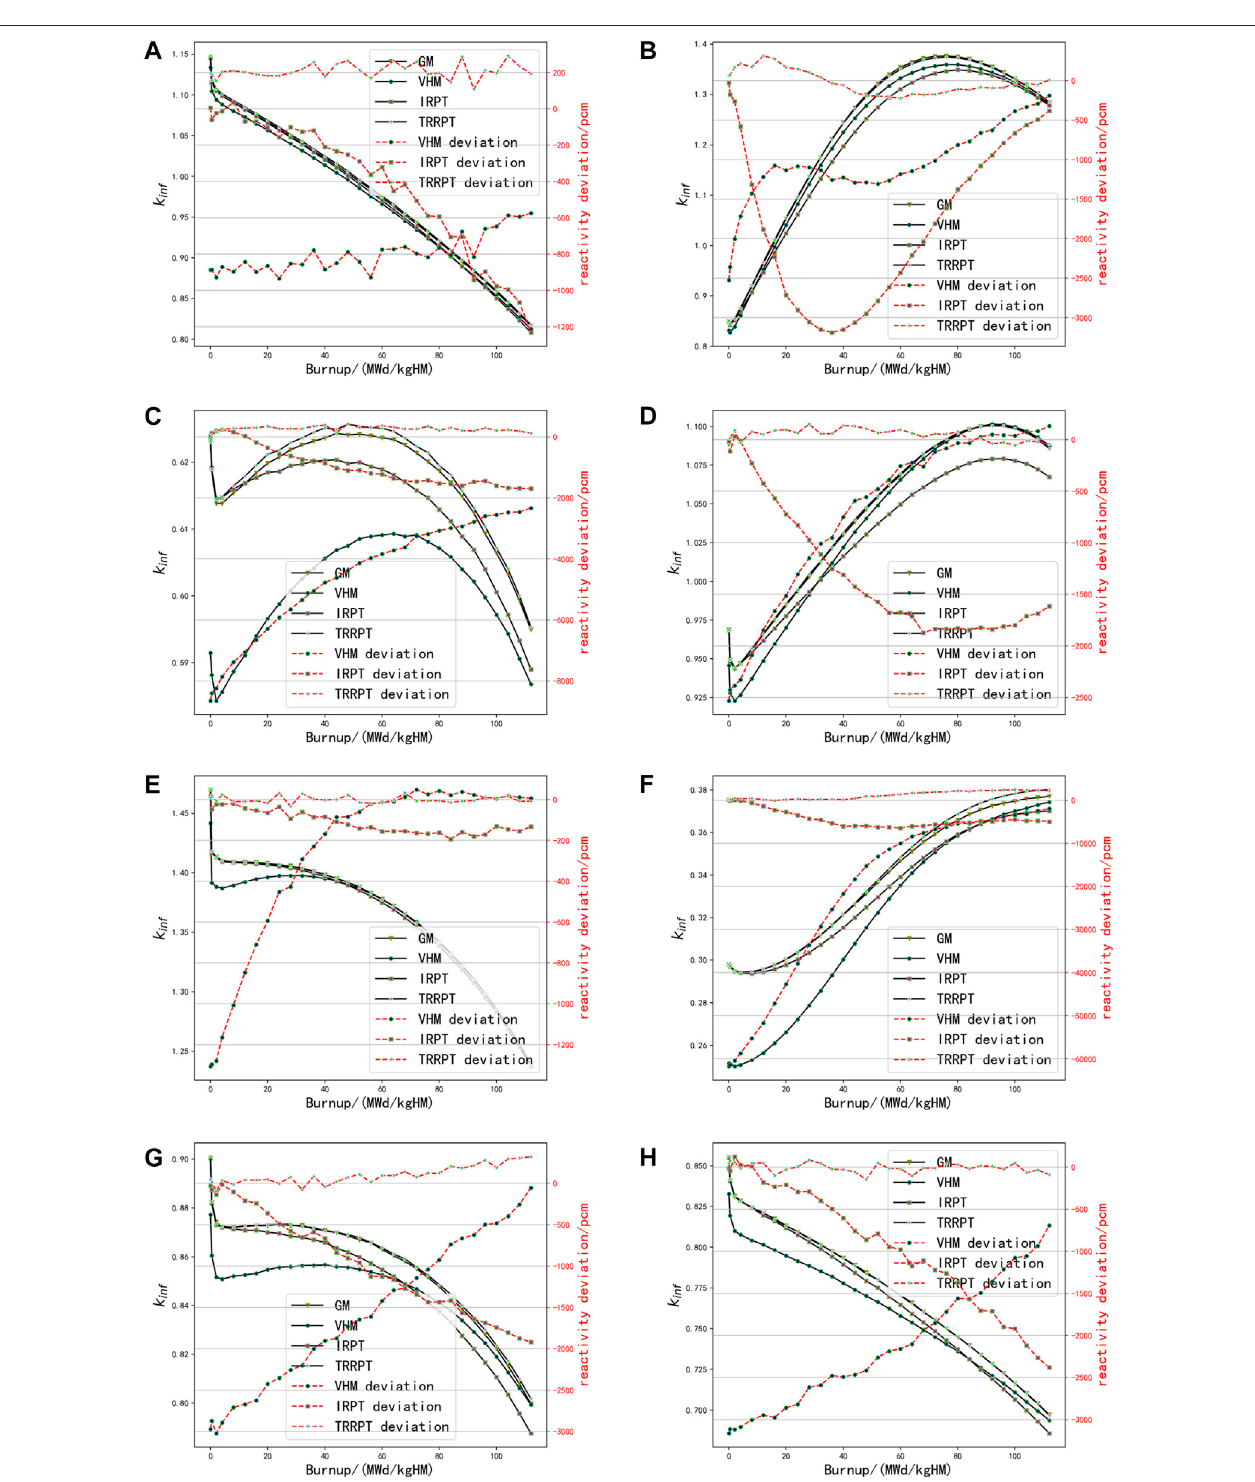
FIGURE 7 | Reactivity and calculation deviation of different methods. (A) Ag-V5%. (B) B4C-V5%. (C) Dy2O3-V5%. (D) Er2O3-V5%. (E) Er2O3-V1%. (F) Eu2O3- V5%. (G) Hf-V5%. (H) In-V5%.